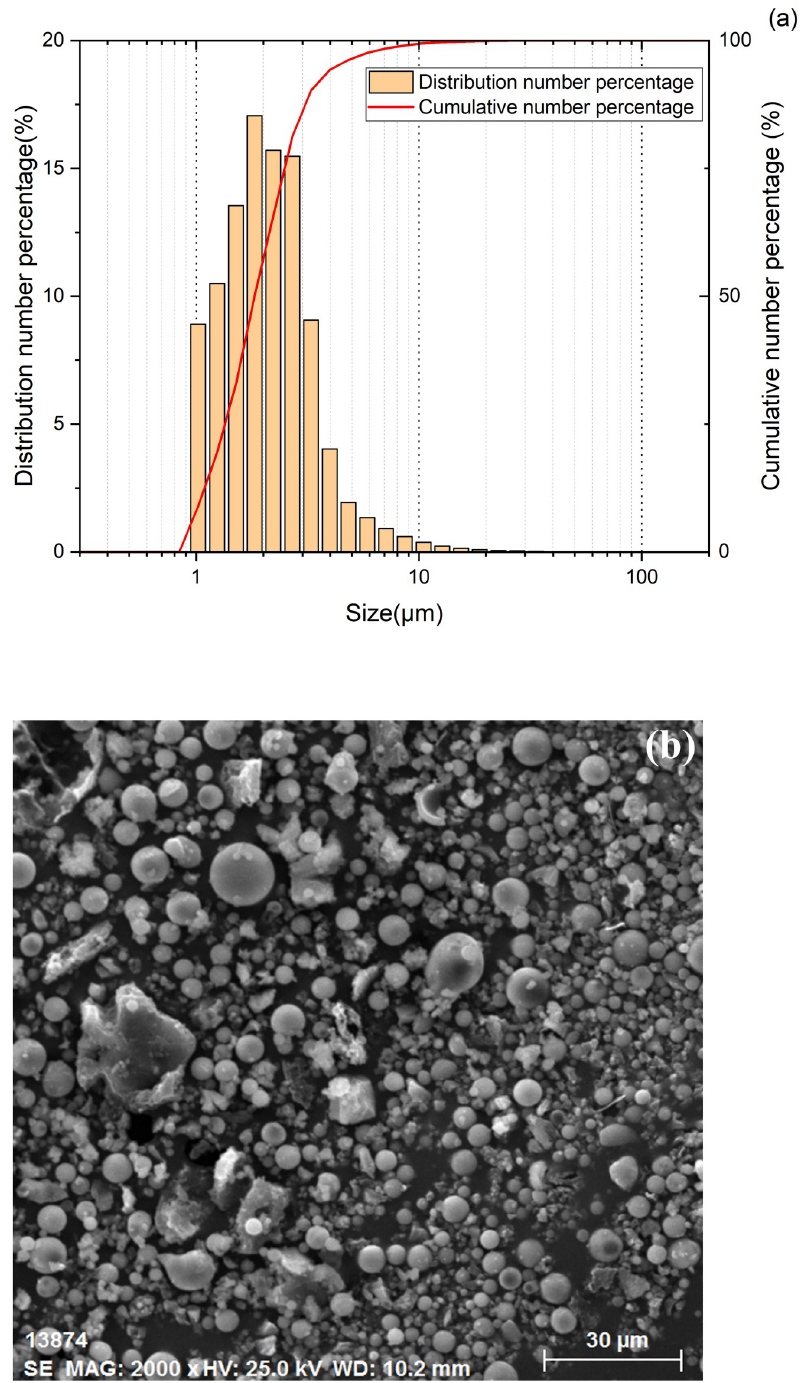
Fig 2. Particle size distribution and ESEM image of the fly ash (a) Particle size distribution, (b) ESEM image.